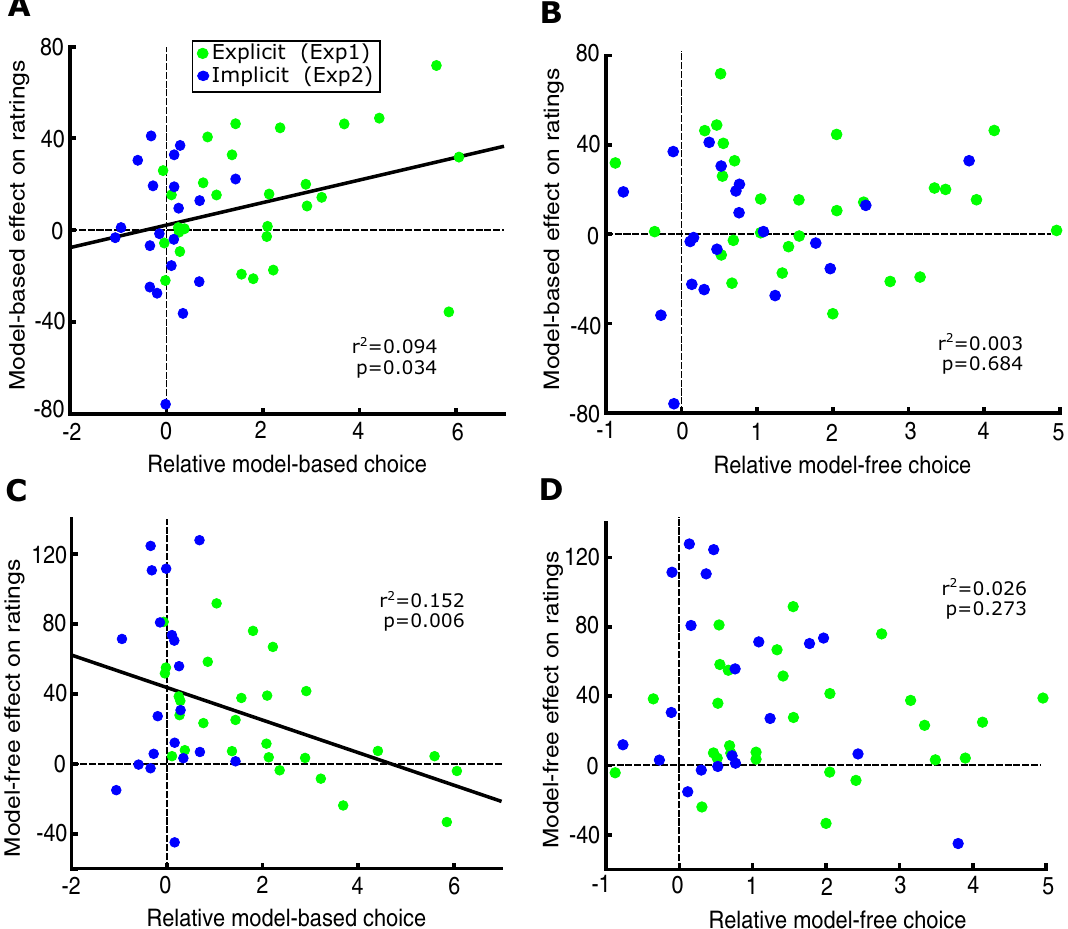
Figure 5. Correlations between choice and ratings. ( A ) Participants who made model-based choices showed the strongest model-based influences on their ratings. ( B ) No significant correlation was observed between model-based ratings and model-free choice. ( C ) Participants who made model-based choices showed smaller effects of model-free valuation on the ratings. ( D ) No significant correlation was observed between model-free ratings and model-free